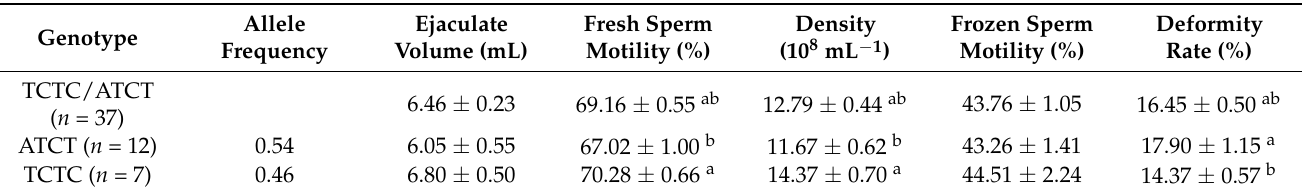
Table 1. Least squares mean (LSM) and stand errors (SE) for semen quality traits of different genotypes of bovine